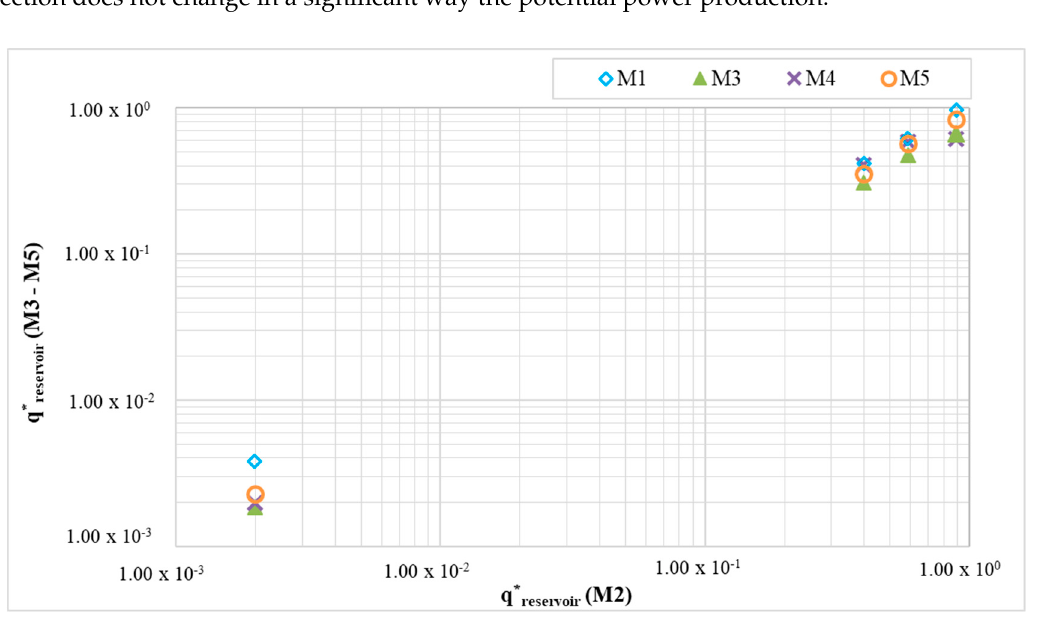
Figure 9. The non-dimensional overtopping flow rate at the rear of the structure, q* reservoir , for the M1–M5 configurations compared with case M2 under normal conditions (Table 1).